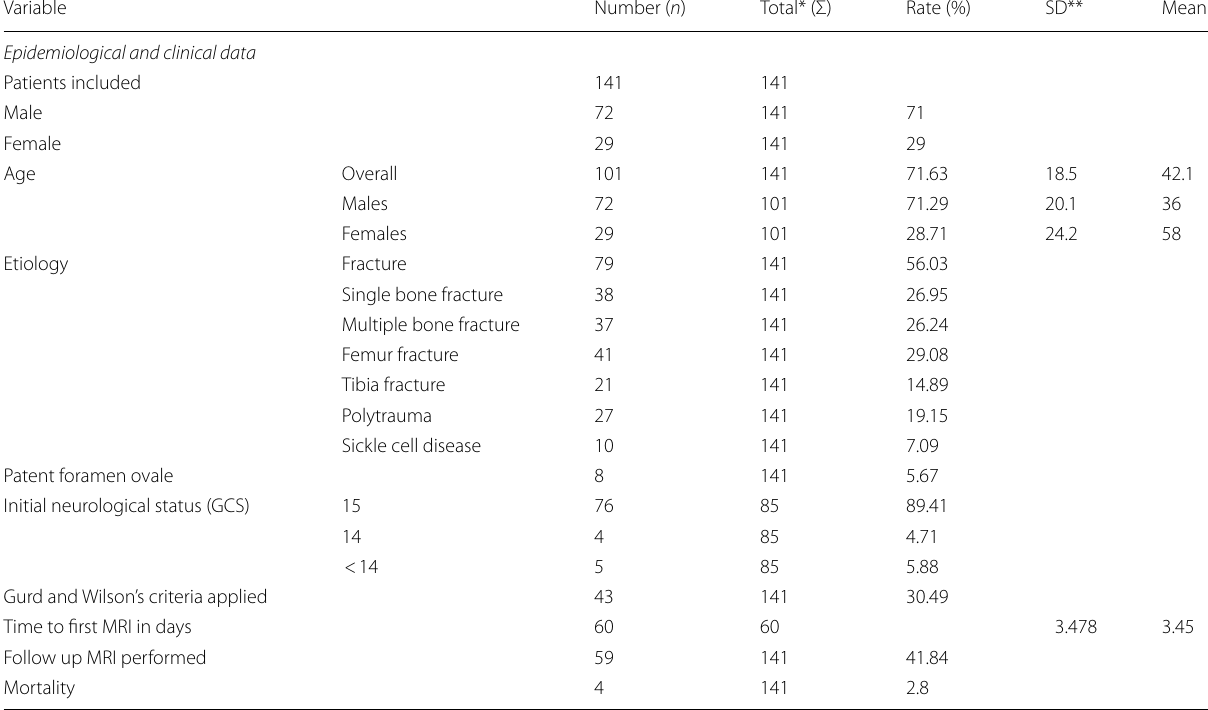
Table 2 Epidemiological and clinical